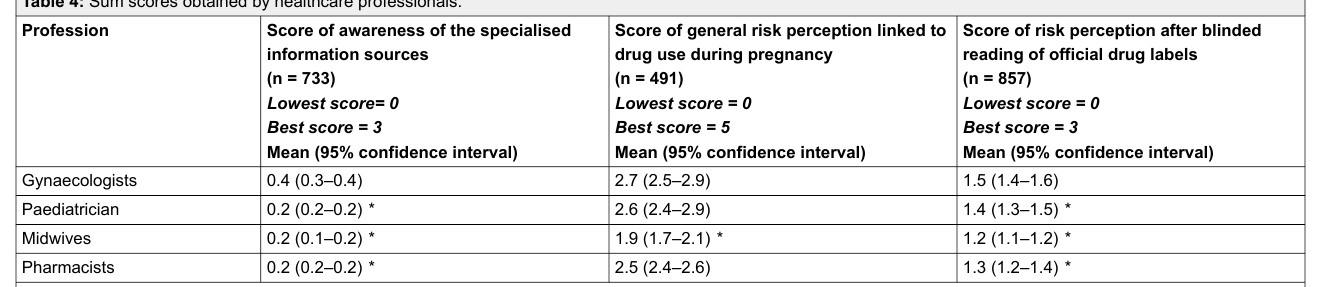
Table 4: Sum scores obtained by healthcare professionals.